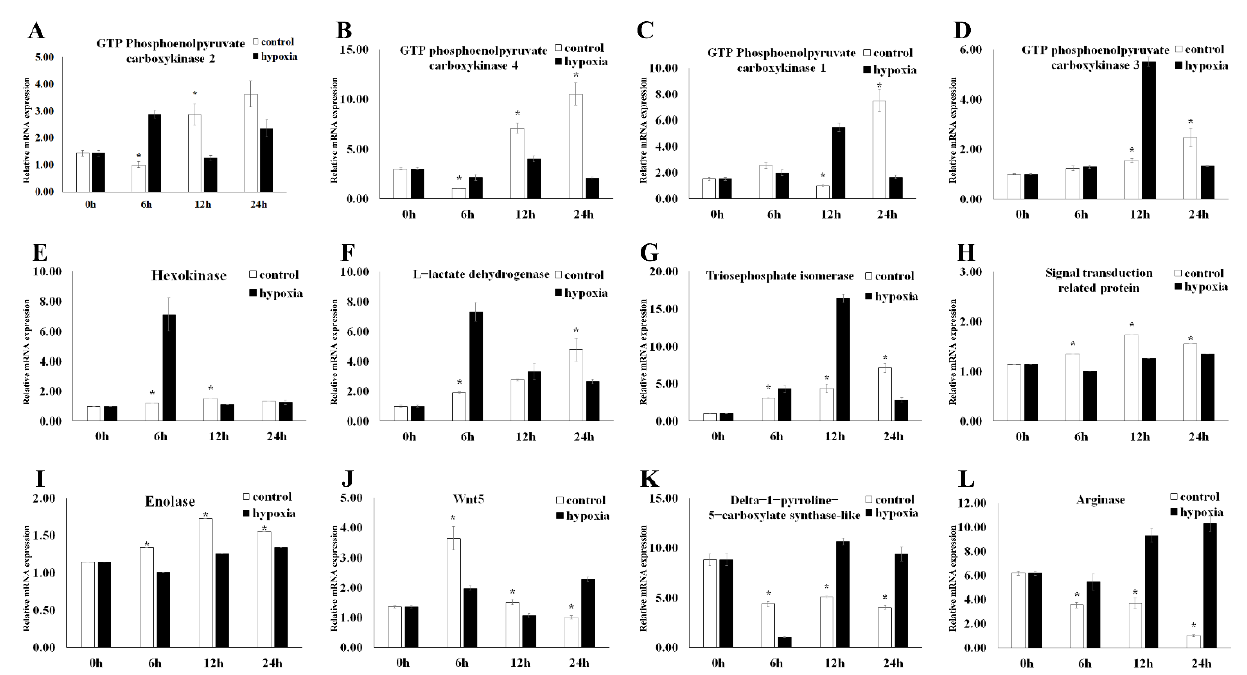
Figure 7. Expression of selected genes in Macrobrachium nipponense at different time points under hypoxia by qRT-PCR. ( A ): Mn-PEPCK2, ( B ): Mn-PEPCK4, ( C ): Mn-PEPCK1, ( D ): Mn-PEPCK3, ( E ) Mn-HK, ( F ) Mn-LDH, ( G ) Mn-TPI , ( H ) Mn-STP, ( I ) Mn-ENO, ( J ) Mn-Wnt5, ( K ) Mn-P5CS, ( L ) Mn-ARG. Data are shown as means ± SD of three replicates in various tissues. Statistical analyses are shown with paired t test. Data indicated with asterisks are significantly different ( p < 0.05) between treatment and control groups.